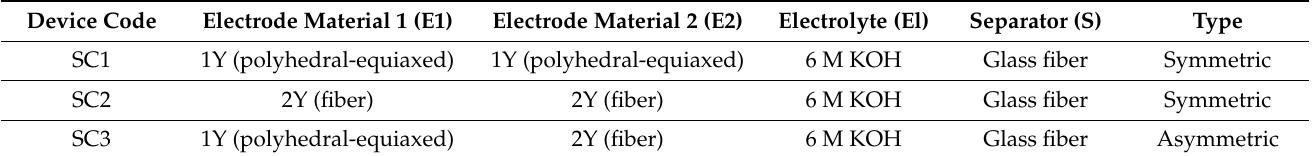
Table 1. Cell components of symmetric and asymmetric supercapacitor devices.